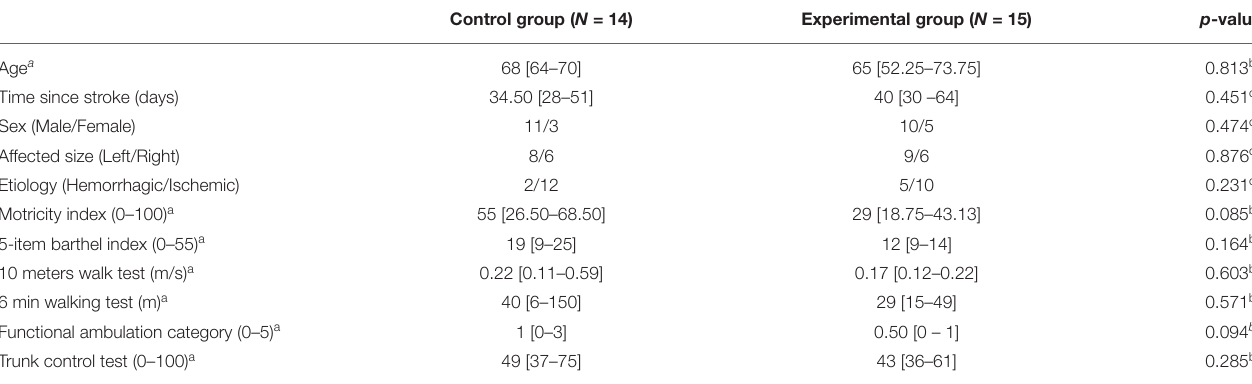
TABLE 1 | Demographic characteristics and functional outcome measures at baseline ( N = 29).